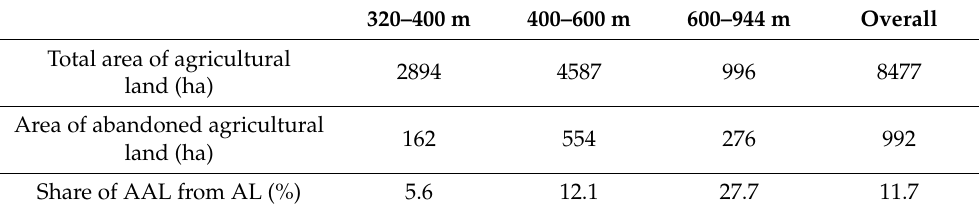
Table 9. Occurrence of abandoned agricultural land (AAL) and agricultural land (AL) and AAL proportion on AL according to